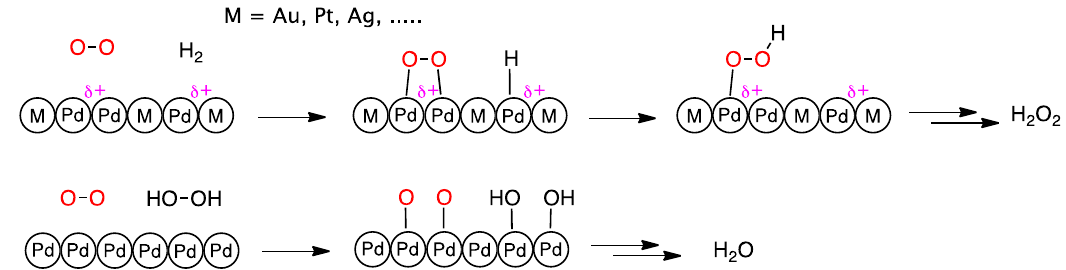
Figure 4. Effect of the presence or absence of a second metal in O 2 and H 2 O 2 chemisorption leading respectively to hydrogen peroxide or water formation.